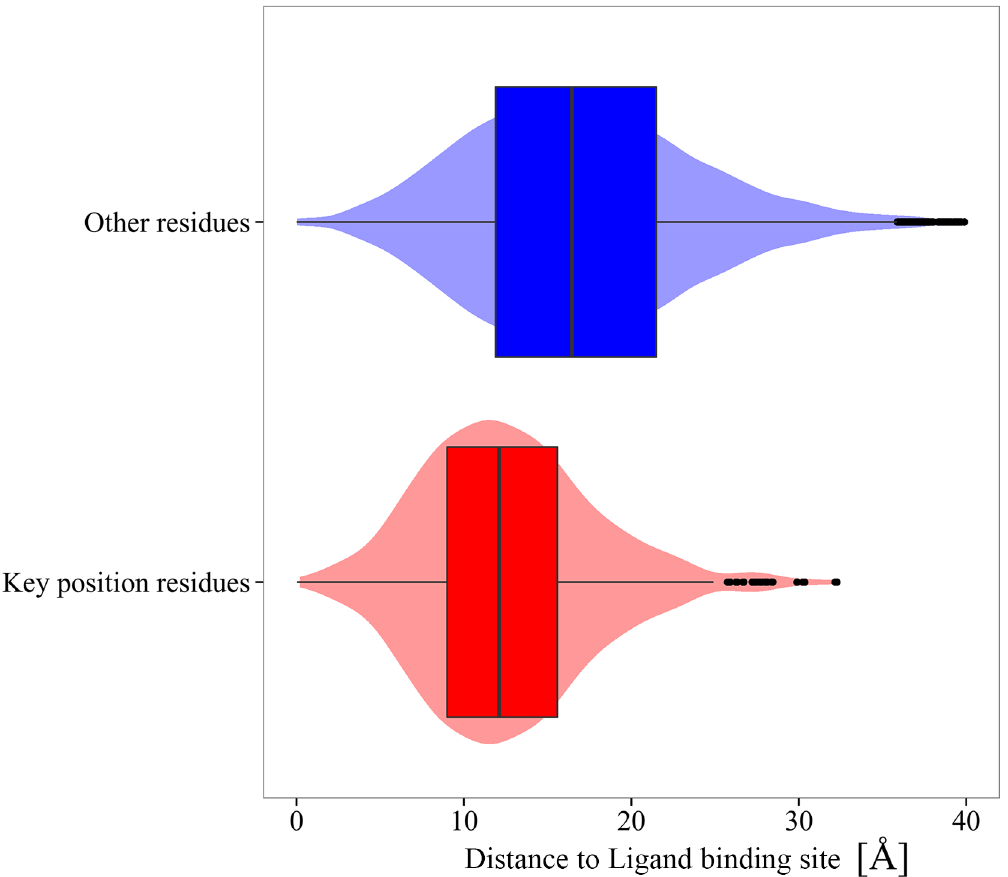
Fig 5. Distribution of the distances of key positions (red) and the rest of residues (blue) to the center of mass of protein active site.